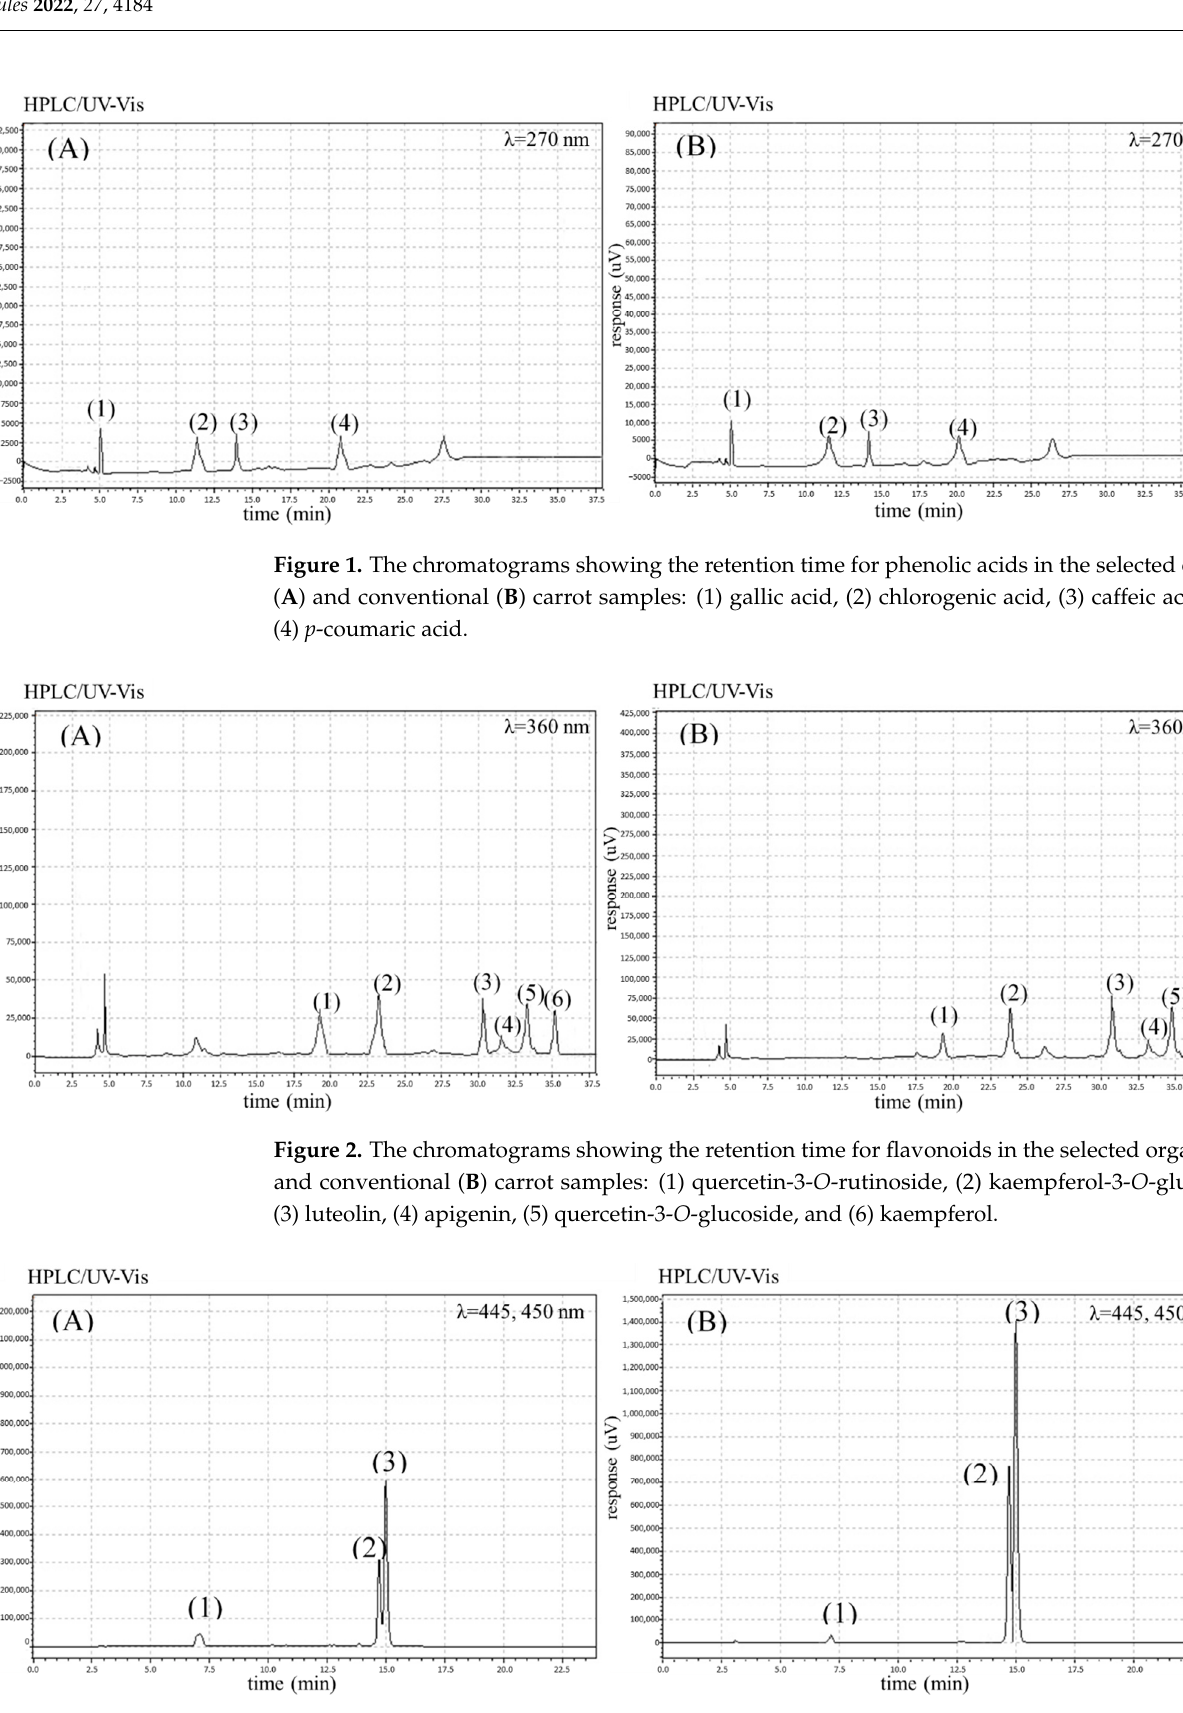
Figure 3. The chromatograms showing the retention time for carotenoids in the selected organic ( A ) and conventional ( B ) carrot samples: (1) lutein, (2) α -carotene, and (3) β -carotene.